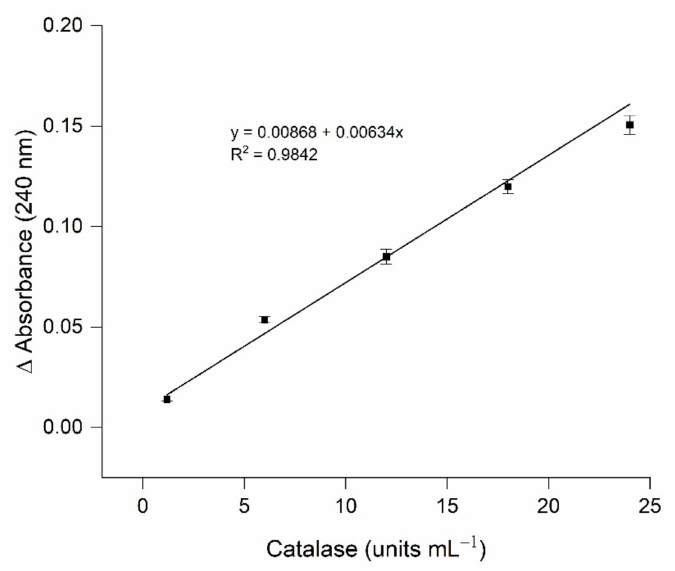
Figure 3. Calibration curve for absorbance versus catalase units per